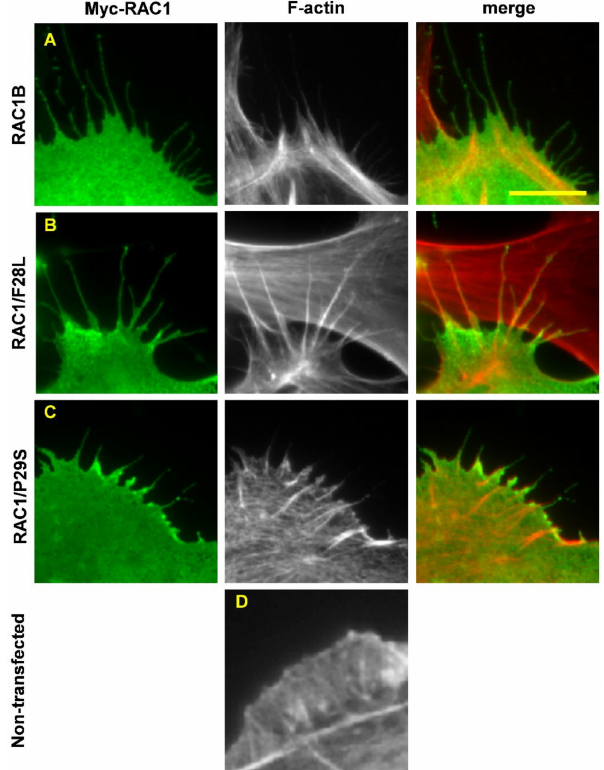
Figure 2. Fast-cycling RAC1 mutants trigger the formation of filopodia in fibroblasts. Human BJ/SV40T fibroblasts were transfected with Myc-RAC1B ( A ), Myc-RAC1/F28L ( B ), Myc-RAC1/P29S ( C ), or a non-transfected control ( D ). Myc-tagged RAC1 variants were visualized using a mouse anti-Myc antibody, followed by an Alexa Fluor 488-conjugated anti-mouse antibody. Filamentous actin was visualized with TRITC-conjugated phalloidin. Scale bar, 10 µ m.